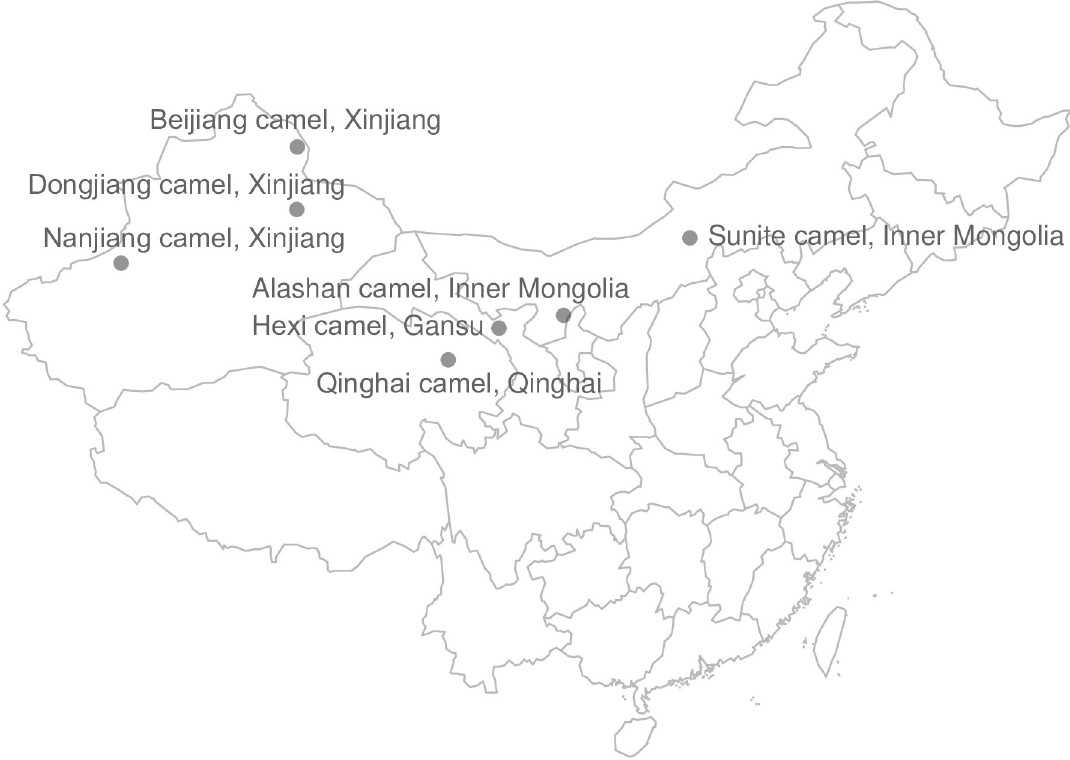
Fig 1. A geographical distribution map of seven domestic Bactrian camel populations in China. ALS, Alashan camels; BJ, Beijiang camels; DJ, Dongjiang camels; HX, Hexi camels; NJ, Nanjiang camels; QH, Qinghai camels; SNT, Sunite camels.